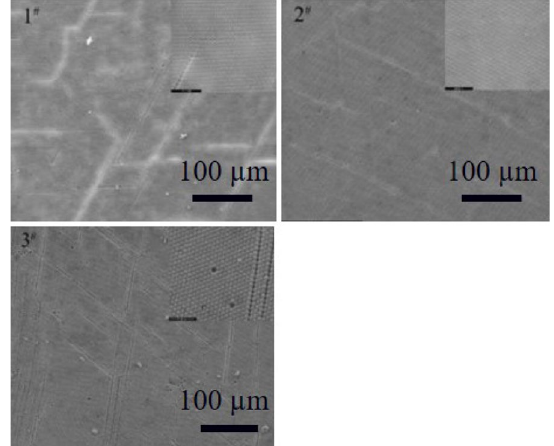
Figure 10 SEM images: 1 # water, 2 # ethanol: water ethanol: water 4: 6 (v%) of the 3D photonic crystal (111) with opal = structure prepared from different suspensions